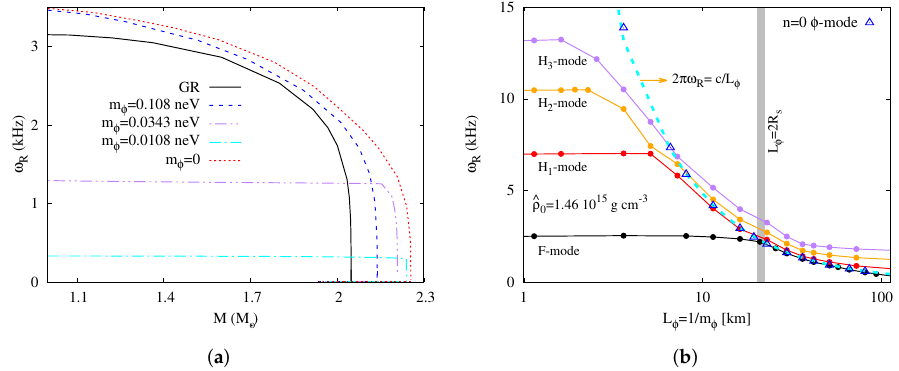
Figure 5. Polar QNMs of neutron stars in R 2 gravity: ( a ) frequency ω R vs. mass M of the l = 0 F mode for several values of a , also shown are the GR values and the massless case; ( b ) frequency ω R vs. scalar Compton wavelength L ϕ for the F mode, H modes and ϕ mode for a given neutron star central density. The equation of state is fixed